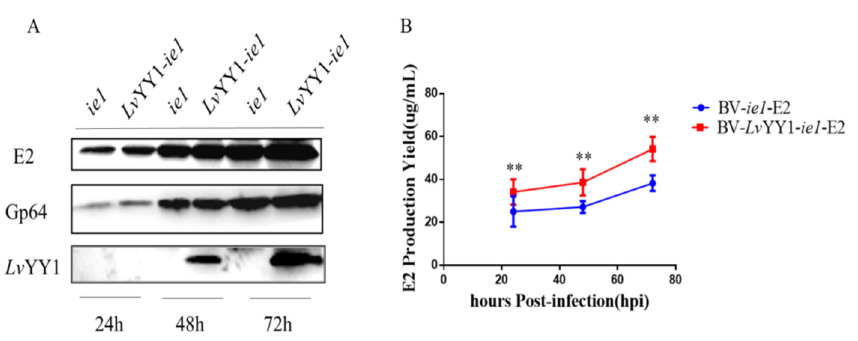
Figure 5. Comparative expression levels of CSFV E2 based on WSSV ie1 and its enhancer ( Lv YY1). ( A ) Western blot detection of Lv YY1 and E2 protein expression in Sf-9 insect cells infected with recombinant baculoviruses. BV- ie1 -E2 or BV- Lv YY1- ie1 -E2 infected Sf-9 cell lysates were harvested at di ff erent times after infection and used for analysis. E2 protein (55 kDa) was detected by mouse anti-E2 polyclonal antibody, and Lv YY1 protein (60 kDa) was analyzed by anti-Flag monoclonal antibody. Anti-Gp64 was included as an internal control (Supplemental Materials). ( B ) BV- Lv YY1- ie1 -E2 and BV- ie1 -E2 cultured in 6-well cell culture plates was compared with standard E2 protein solution (50 ug / mL). Results were shown as mean ± SD for three independent experiments. ** p < 0.01, unpaired Student’s t -test.